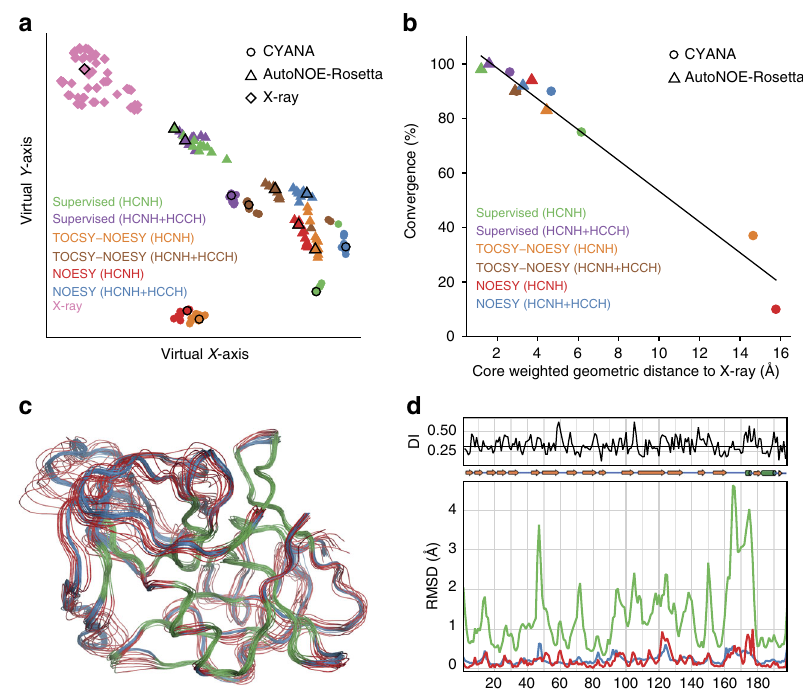
Fig. 4 Ensemblator 25, 26 analysis of α -lytic protease NMR and X-ray ensembles. a t-SNE dimensionality reduction results showing the relationships of the aLP models. The shape and color of each point (see in plot key) convey the method and the data used to generate that model; a black outline highlights the most representative (exemplar) for each type of model. b For each type of NMR ensemble, the convergence of the ensemble during re fi nement is compared to the distance of its exemplar to that of the X-ray ensemble. Shapes and colors of each point (see in plot key) convey the method and the data used to generate that model. The best fi t to these data (black line) has an adjusted R 2 of 0.96. c Wire diagram showing the traces of the backbone heavy atoms for the 4D-CHAINS/autoNOE-Rosetta ensemble obtained using supervised assignments and HCNH NOEs (red) and the X-ray ensemble (blue). The de fi ned core atoms (21.4% of all atoms using a 1.6 Å cutoff) are shown in green. d Shown are the per residue global backbone heavy atom variation (bottom panel) for the 4D-CHAINS/autoNOE-Rosetta ensemble obtained using supervised assignments and HCNH NOEs (green) and the X-ray ensemble (blue), along with the closest approach distance for models in each group (red). The discrimination index (top plot, black line) reveals regions of similarity (low values) and difference (high values); the median discrimination (DI) index is indicated by a horizontal